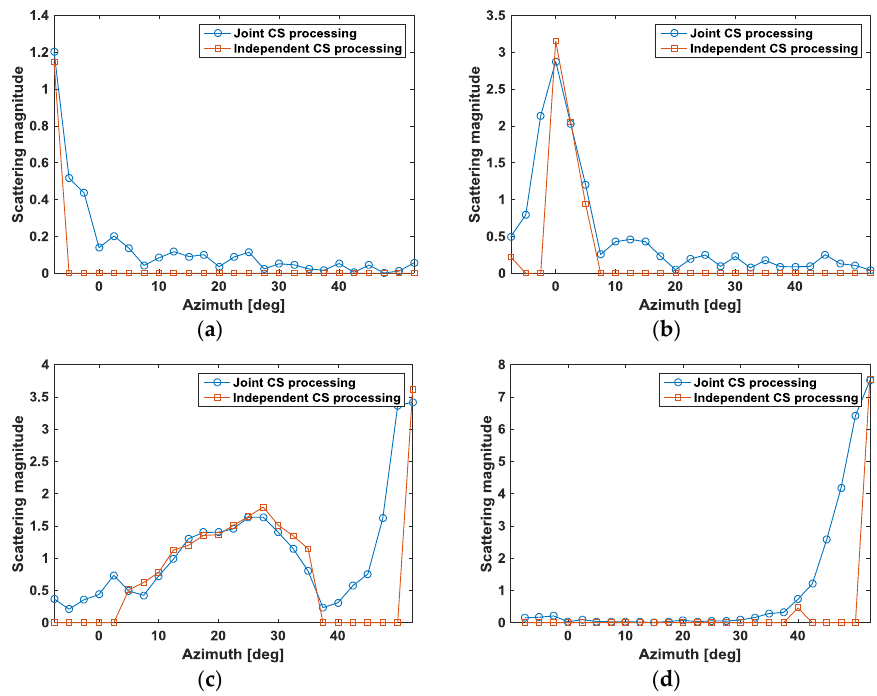
Figure 18. Magnitude of reflectivity response over full range of aspects for several sample pixels. ( a ) Sample pixel 1; ( b ) Sample pixel 2; ( c ) Sample pixel 3 and ( d ) sample pixel 4.